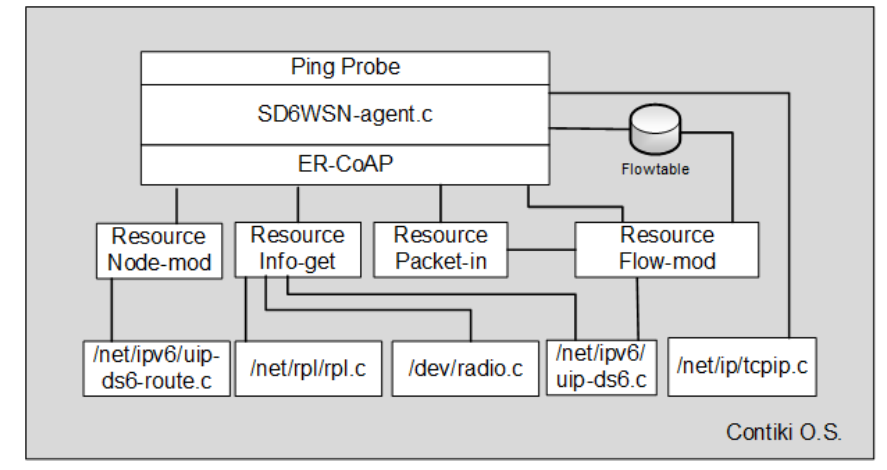
Figure 8. Integration of the SD6WSN agent with Contiki